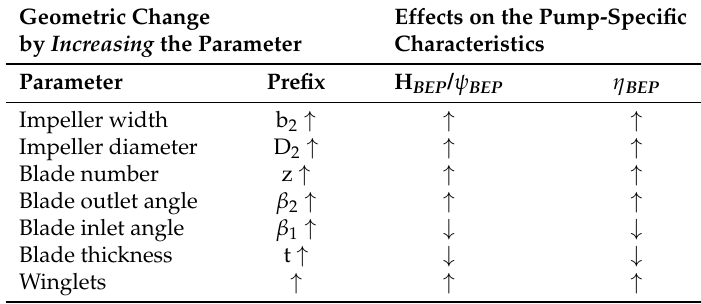
Table 3. Geometric changes to the impeller and their effects on the pump-specific characteristics. Geometric Change Effects on the Pump-Specific by Increasing the Parameter